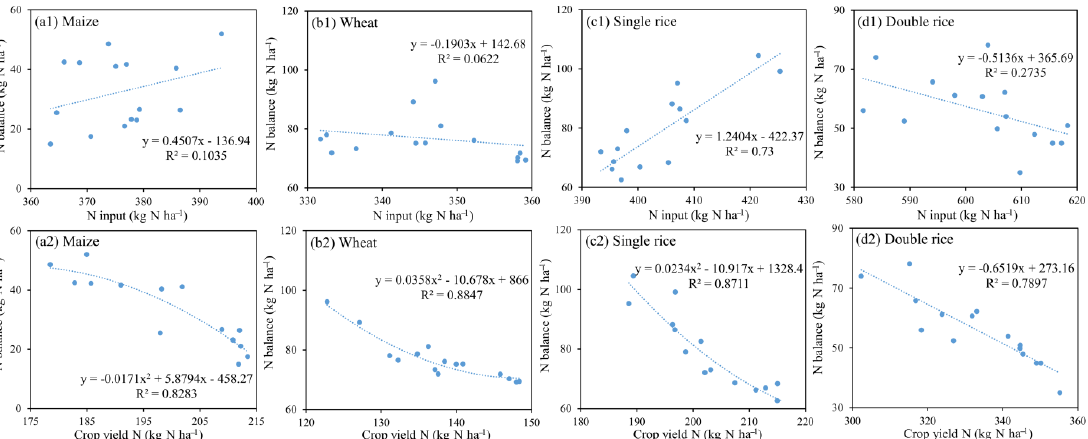
Figure 9. The relationship between N balance and N input from chemical fertilizer and manure for ( a1 ) Maize, ( b1 ) Wheat, ( c1 ) Single rice and ( d1 ) Double rice and relationship between N balance and crop yield N for ( a2 ) Maize, ( b2 ) Wheat, ( c2 ) Single rice and ( d2 ) Double rice during the period of 2004 – 2018 across China’s farmlands, respectively.